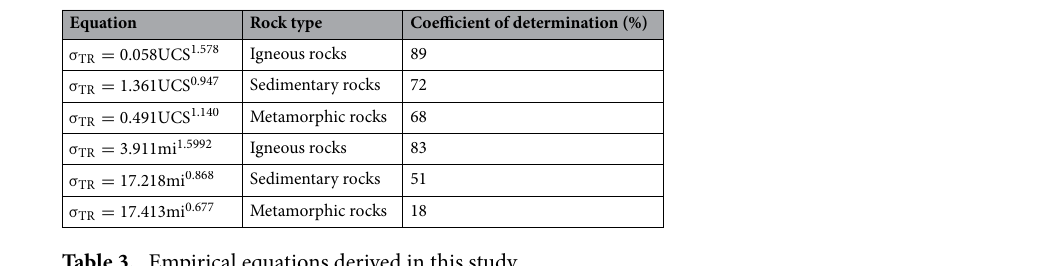
Table 3. Empirical equations derived in this